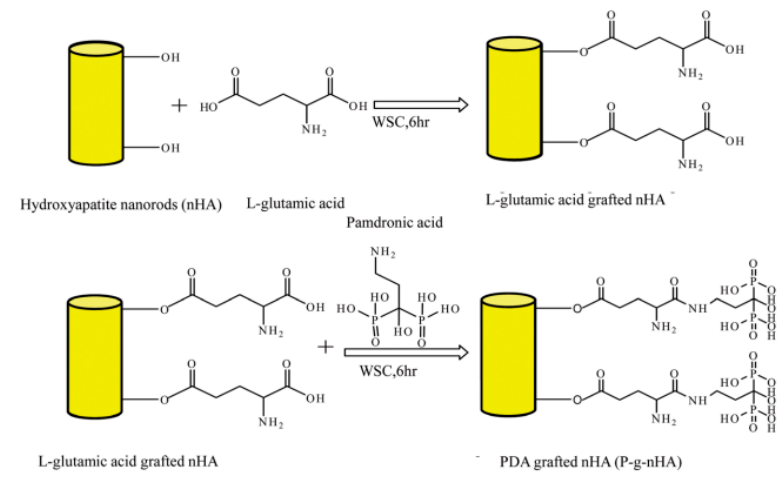
Figure 5. Schematic diagram depicting the grafting of pamidronic acid at the surface of the nHA particles. Reprinted from Ref. [28] with copyright (2012) permission from the Royal Society of